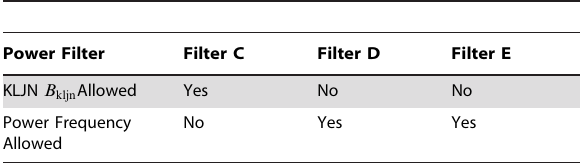
Table 2. Truth table of the Power Filter in State 1 (inactive